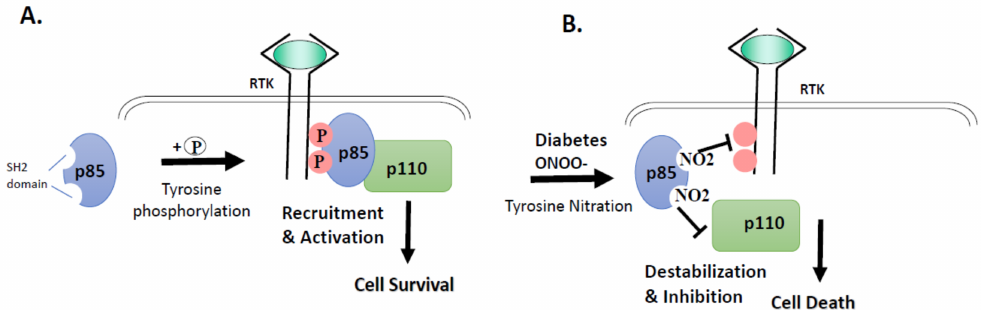
Figure 8. Conceptual frame of the study results. ( A ) Under normal physiological conditions, proper phosphorylation of regulatory subunit of PI3-kinase: p85 by receptor tyrosine kinases (RTK) takes place, resulting in strong association with the catalytic subunit p110, and initiation of cell survival signal. ( B ) Under diabetic or nitrative stress conditions, nitration of p85 subunit—instead of phosphorylation—occurs, resulting in its dissociation from p110 subunit and dysfunction of PI3-kinase and initiation of cell death